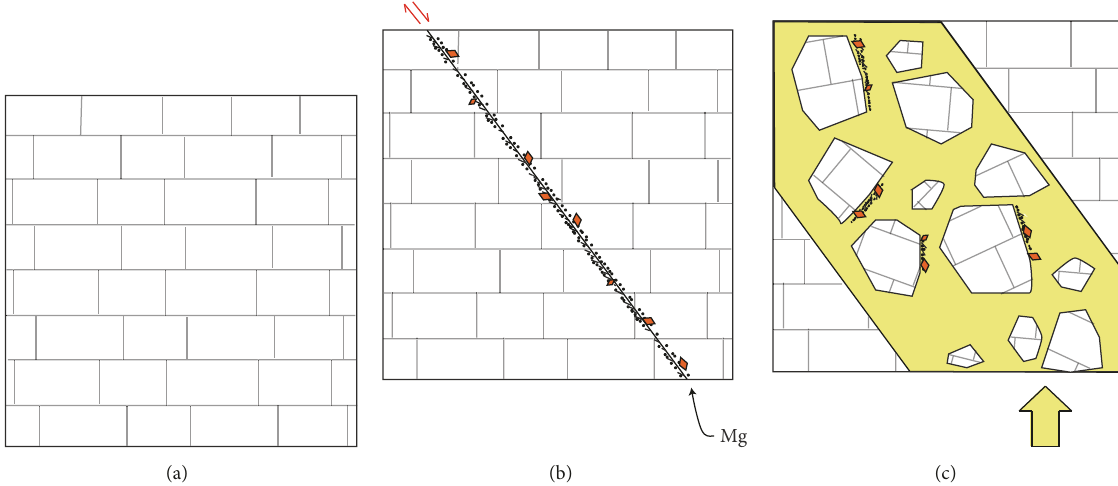
Figure 8: Schematization of the different phases of fluid flow within the chalk succession. (a) Chalk sedimentation. (b) Early synsedimentary fractures, fluid circulation probably coming from the compaction of underlying clays (Lower Cretaceous and Upper Jurassic) and associated dolomitization. (c) Late Cretaceous tectonic reactivation and fluid circulation likely coming from the Sherwood Sandstone and resulting in breccia